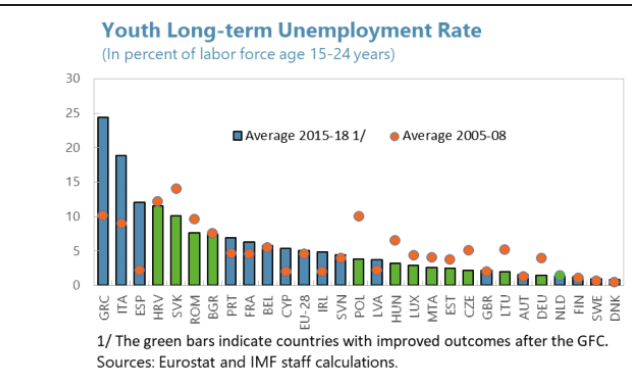
Figure 1. Long-term unemployment indicators.